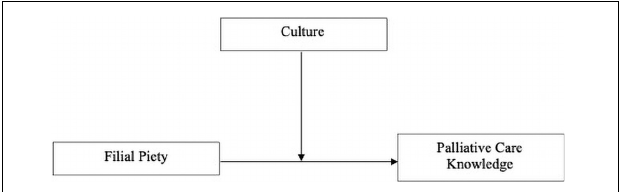
FIGURE 1 | Conceptual model of the mediation